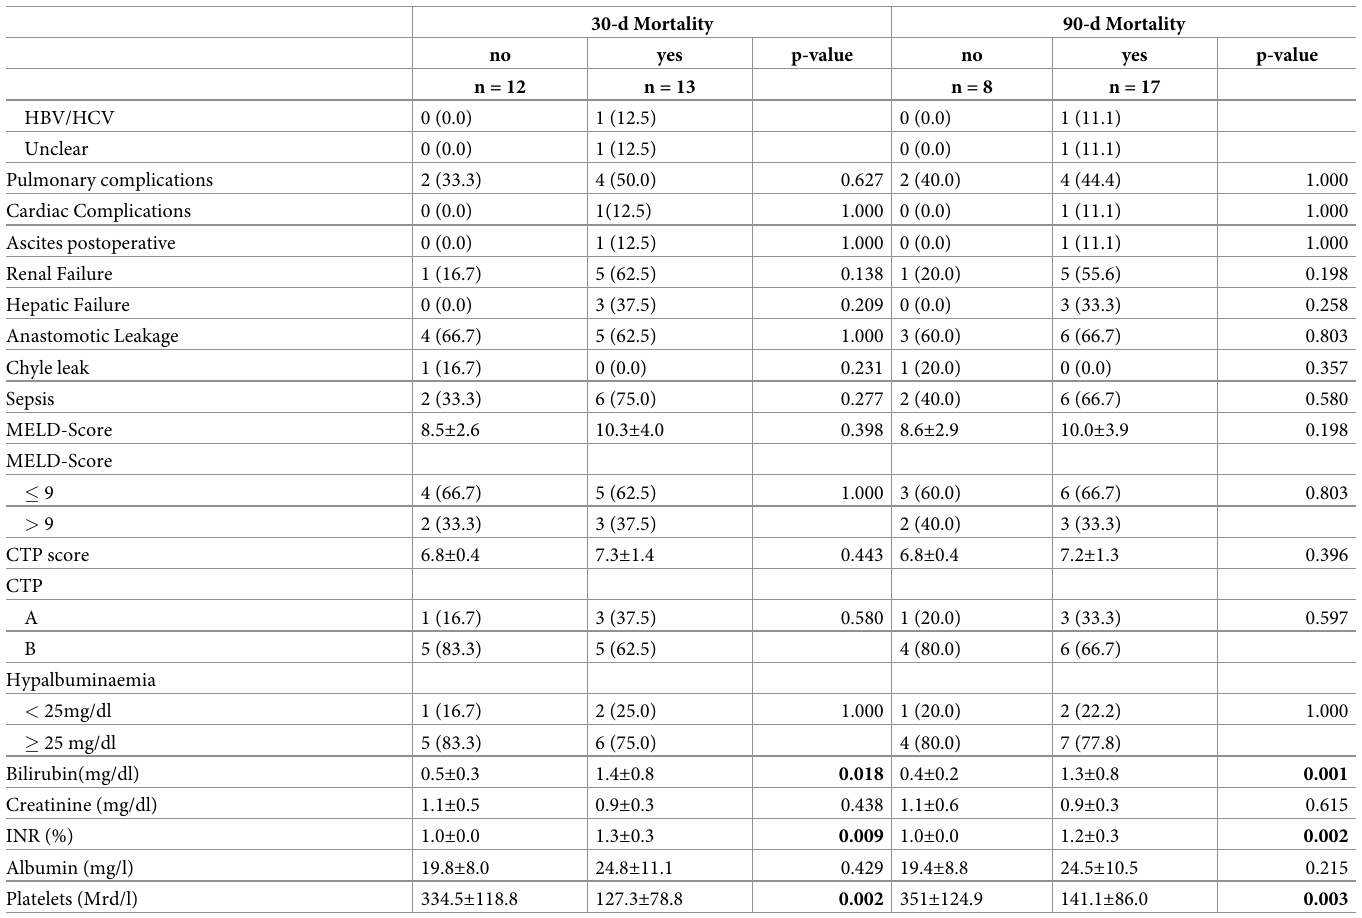
In ROC analysis, MELD score, Child Score and CCI failed in predicting 30-day or 90-day mortality (auROC = 0.644–0.688, S1 and S2 Figs). In contrast, bilirubin and INR proofed excellent prognostic capacity in predicting both, 30-day ad 90-day mortality (bilirubin: 30-d M auROC = 0.875 p = 0.020, 90-d M auROC = 0.944, p = 0.008; INR: 30-d M auROC = 90.6%